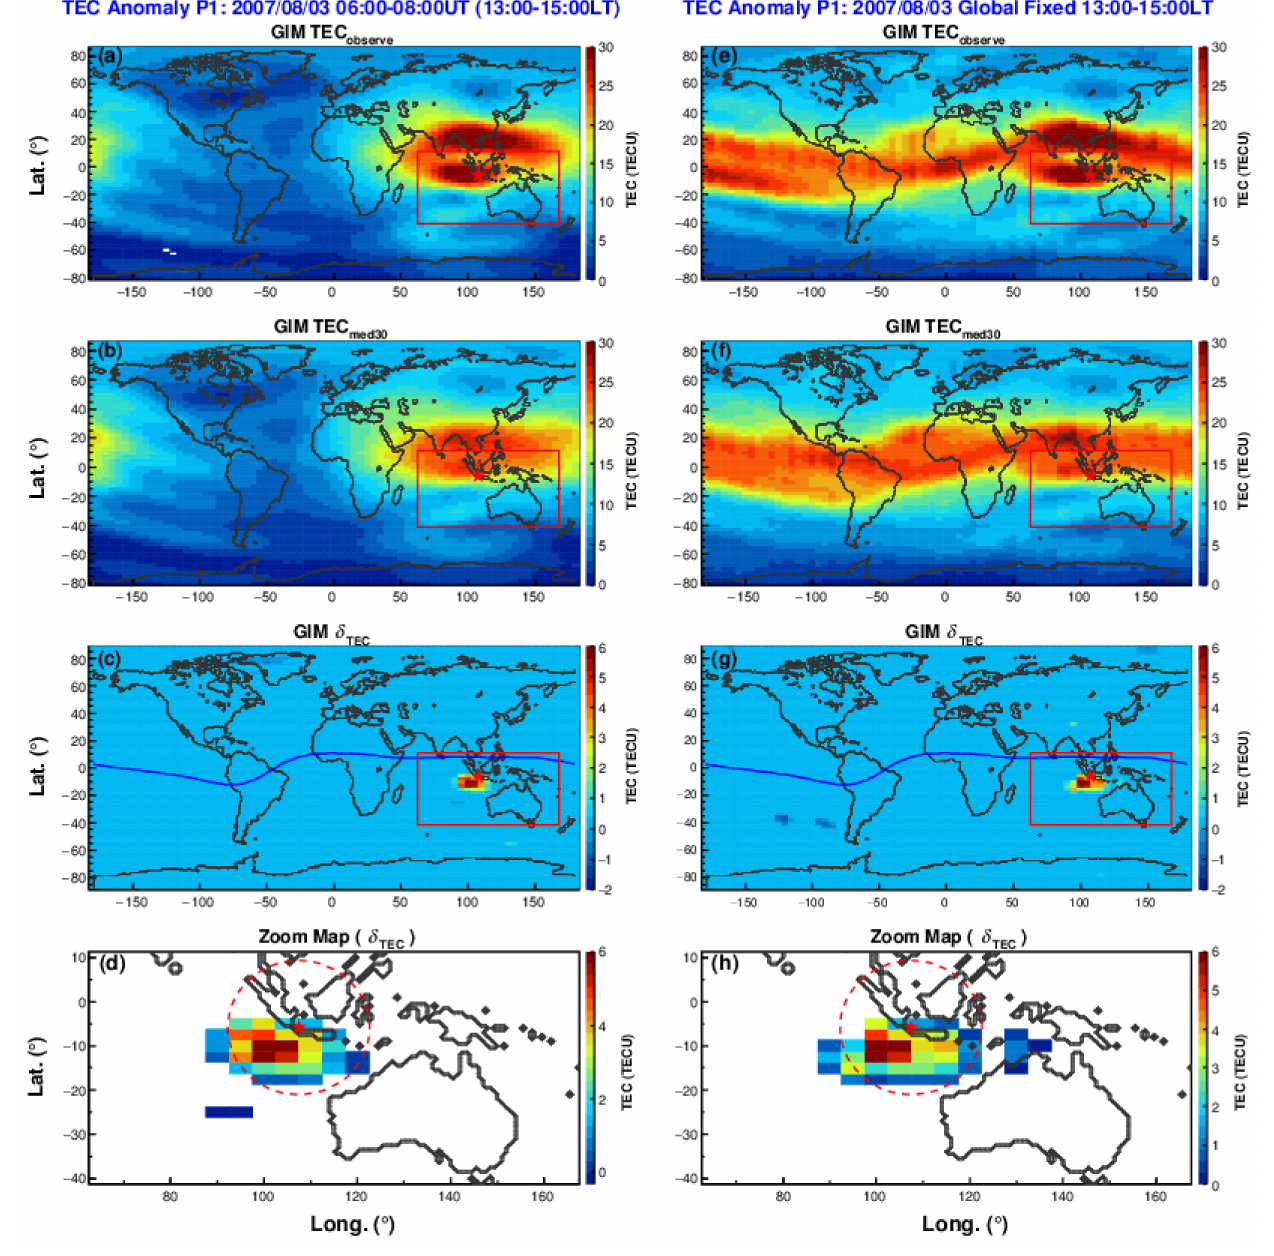
Figure 3. The spatial deviations in GIM TEC during the temporal anomalies period P1. Subpanels ( a – c , e – g ) represent the observe GIM TEC, the 30-day running median one and the deviations of TEC ( δ TEC ) during period P1 universal time and the global fixed local time, respectively. Subpanel ( d , h ) respectively represent the spatial extreme TEC anomalies ( | δ TEC | > 0) with map zooming near the epicenter as marked with the red square in subpanels ( c , g ), and bins with white background means = 0. The blue curves, red stars and dashed circles indicate the magnetic equator, the epicenter δ TEC and the estimated earthquake preparation zone,